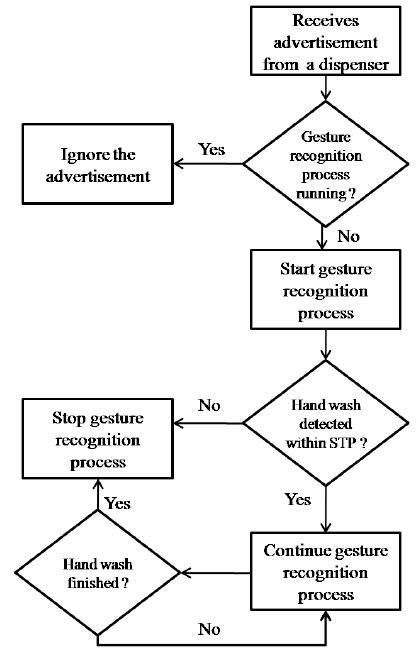
Figure 5: Mechanism for starting and stopping the gesture recog- nition process in a watch